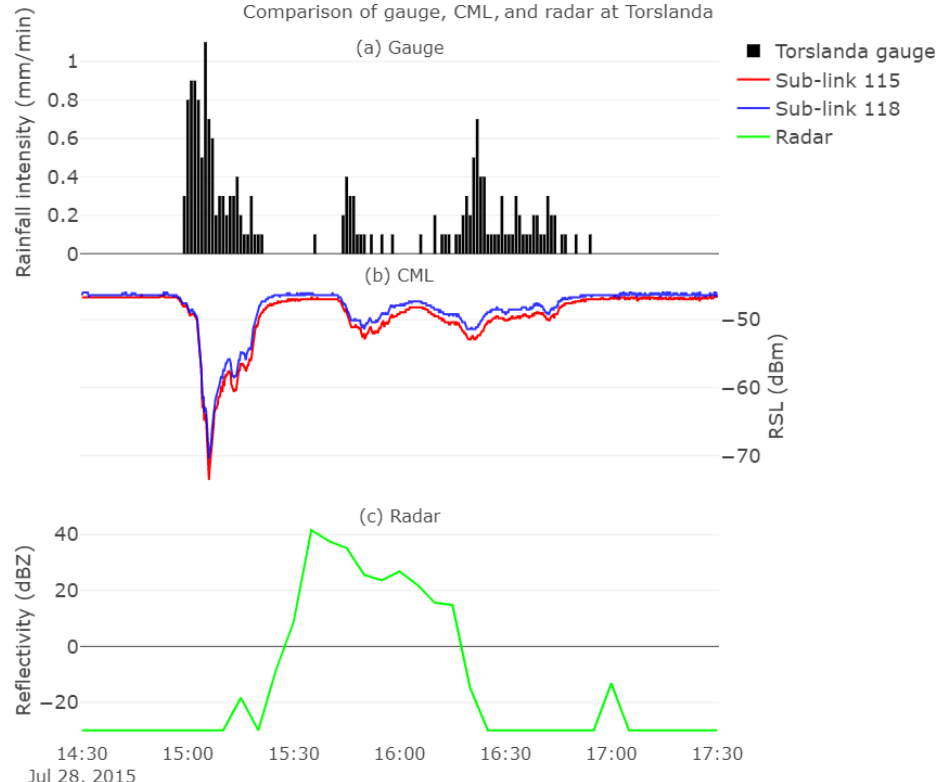
Figure 11. (a) An intense rainfall event at the Torslanda gauge on 28 July 2015, (b) the corresponding RSL signal fade for a nearby microwave link (link 10227 and sub-links 115 and 118), and (c) the reflectivity of the overlying radar pixel. The locations of the gauge and link are shown in Fig. 12. Sub-link 115 is vertically polarized, with a frequency of 28.23GHz, covering a 1.8km distance. Sub-link 118 is identical, except for operating at 29.24GHz. An interactive version of this figure is available together with the data set (see Sect. 6).